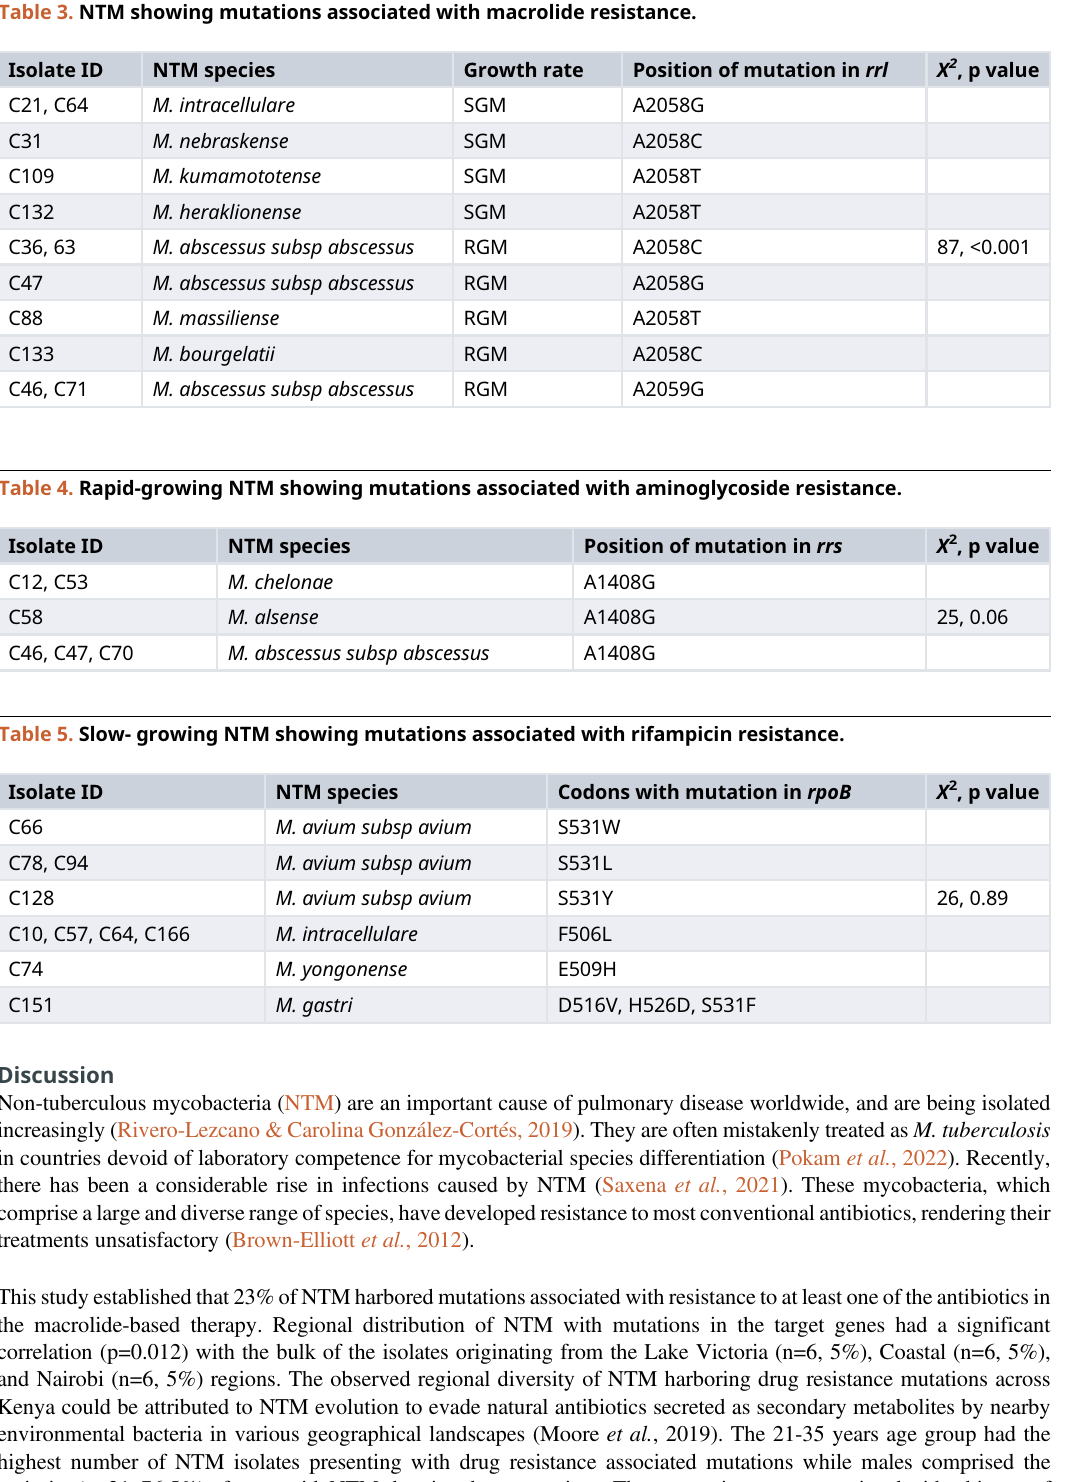
Table 3. NTM showing mutations associated with macrolide